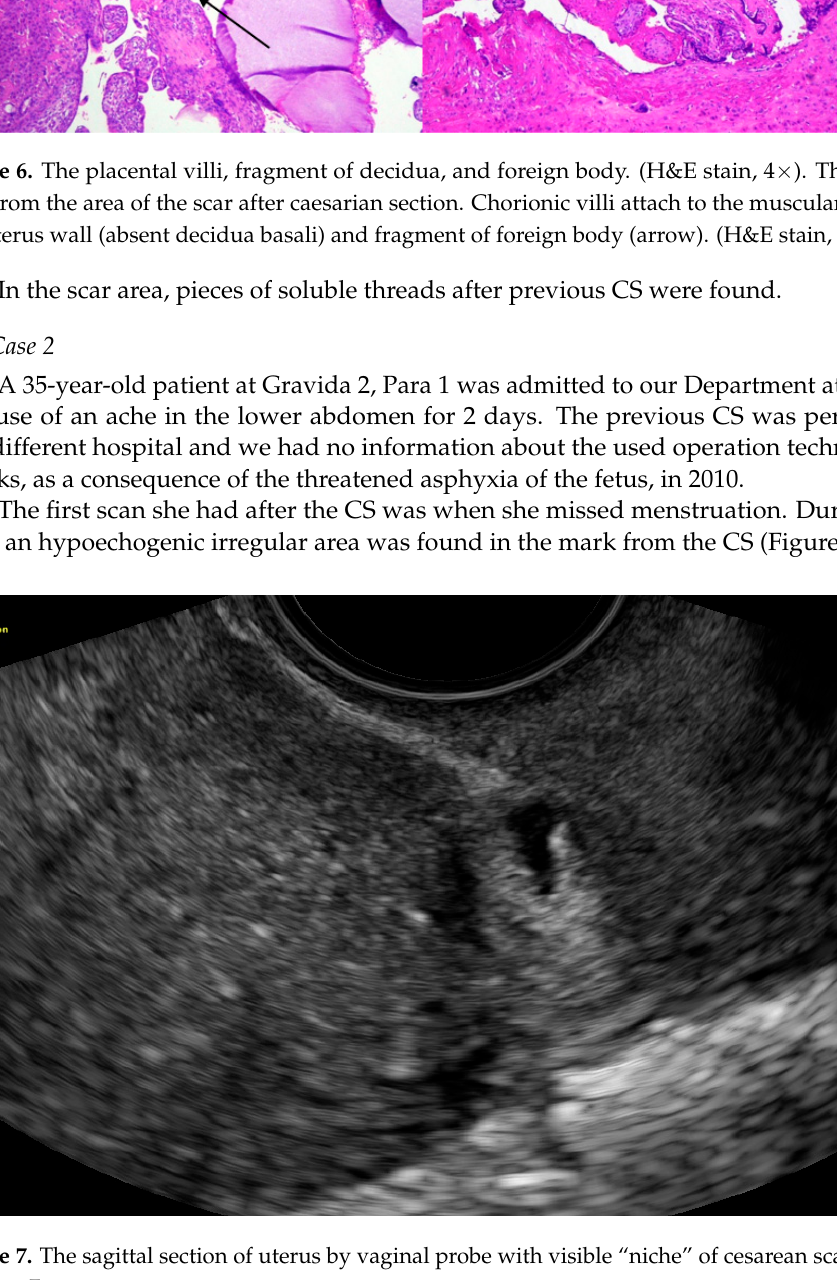
Figure 5. Intraoperative image after the separation of the peritoneum from the anterior wall of the uterus.